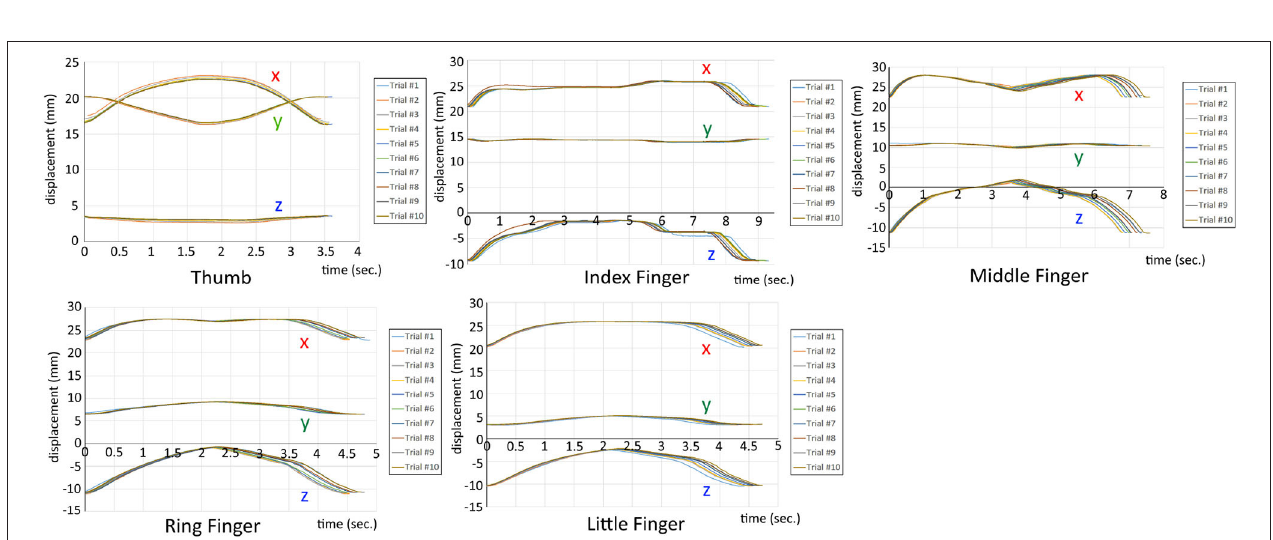
FIGURE 11 | The measurement data of fingertip position for 10 times of flexion/extension motion. The data was sampled at the frequency of 240 Hz.